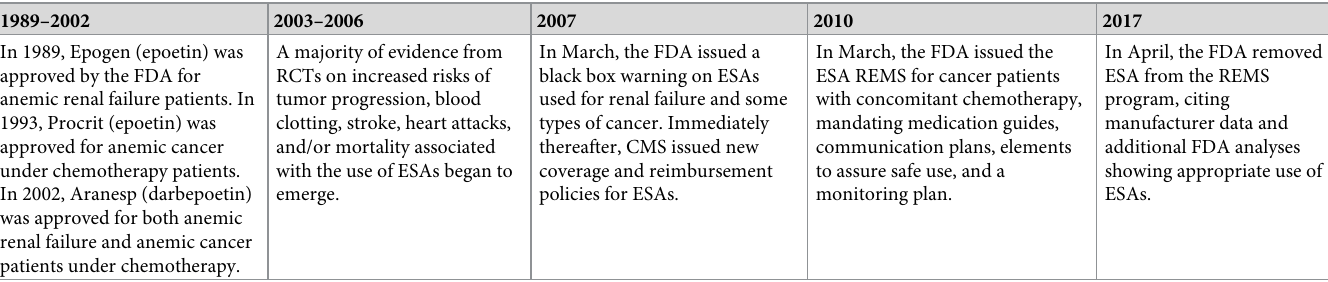
Table 1. Chronicle of regulatory actions and safety information related to